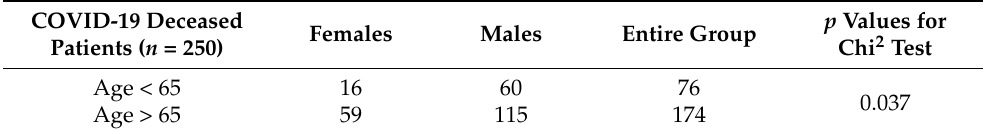
Table 3. Comparative distribution of deaths by age group.